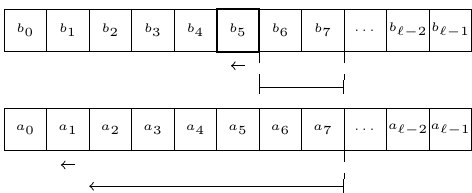
Figure 2: Required bits at the input and output of χ ‘ to set one bit of representative minimum input difference at b 5